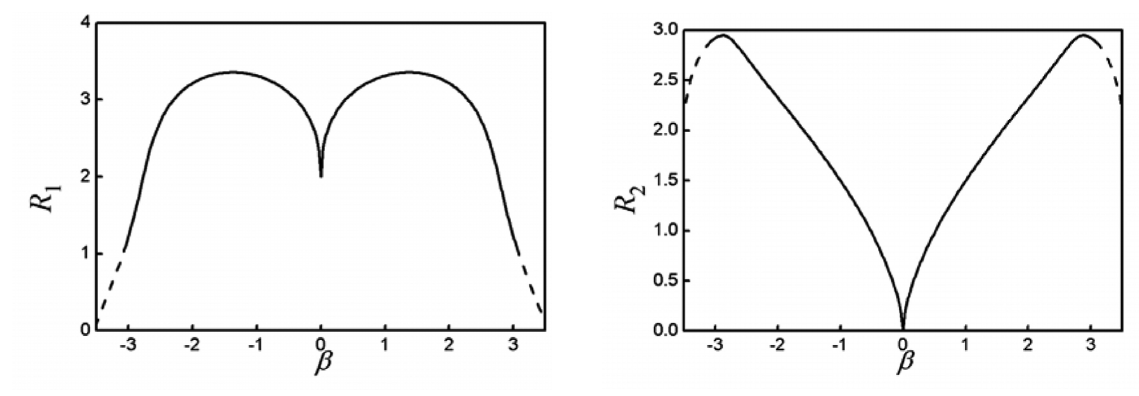
Fig. 5. Variation of R 1 with β . Fig. 6. Variation of R 2 with β